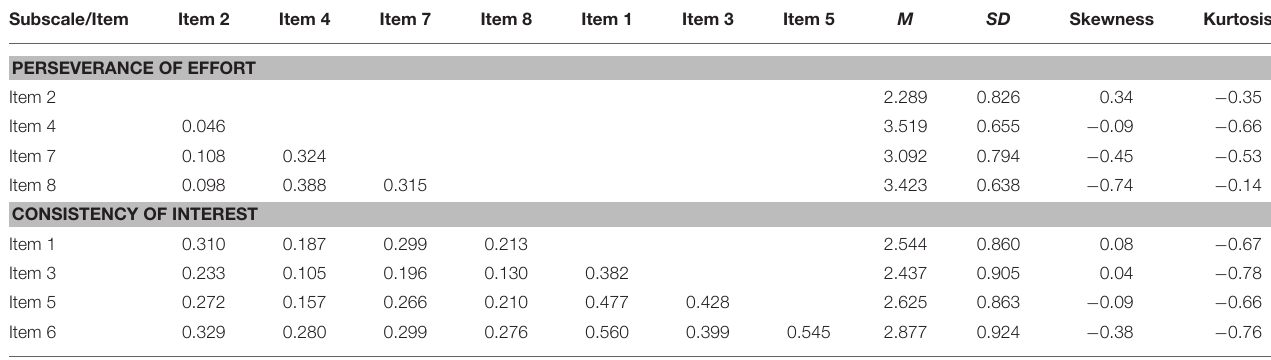
TABLE 2 | Correlations between Translated Grit-S Items and Item-Level Descriptive Statistics. Subscale/Item